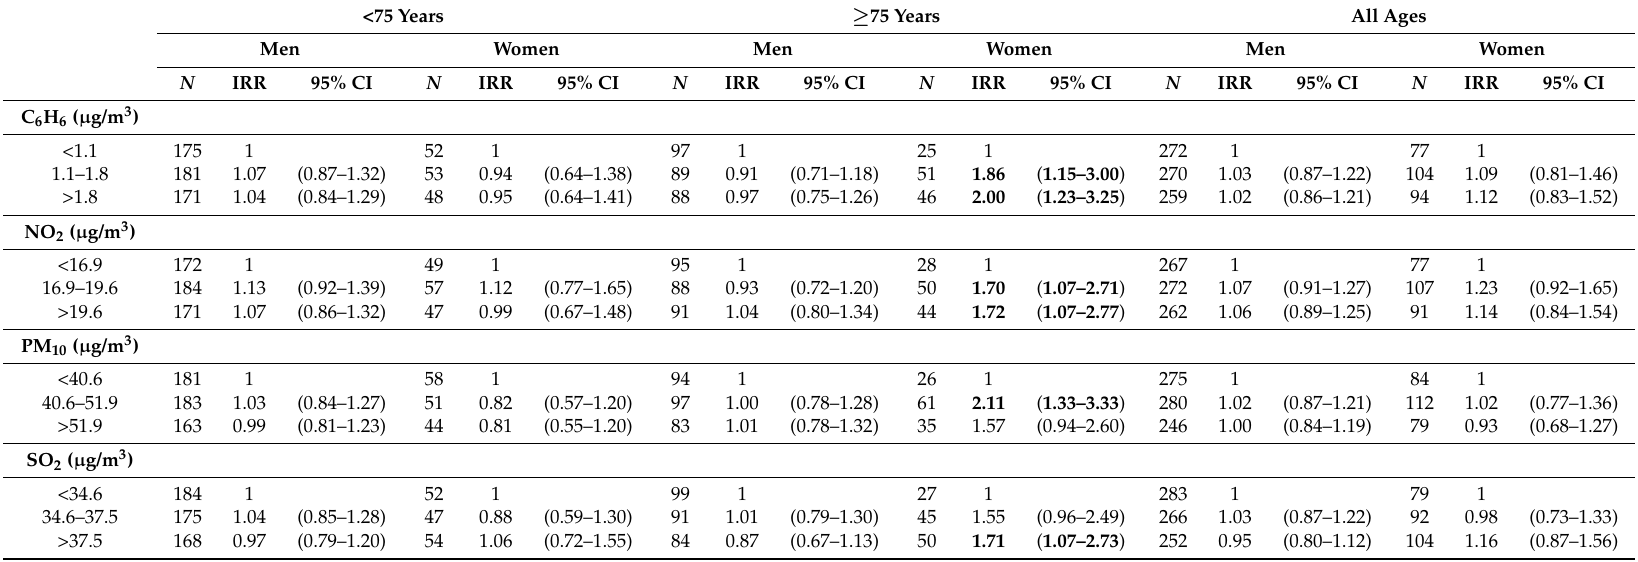
Table 2. Number of incident cases of lung cancer, incidence rate ratio (IRR) with corresponding 95% confidence intervals (CI), by sex, tertile of exposure, and age group. 1995–2009 in 14 municipalities. Statistically significant results are reported in